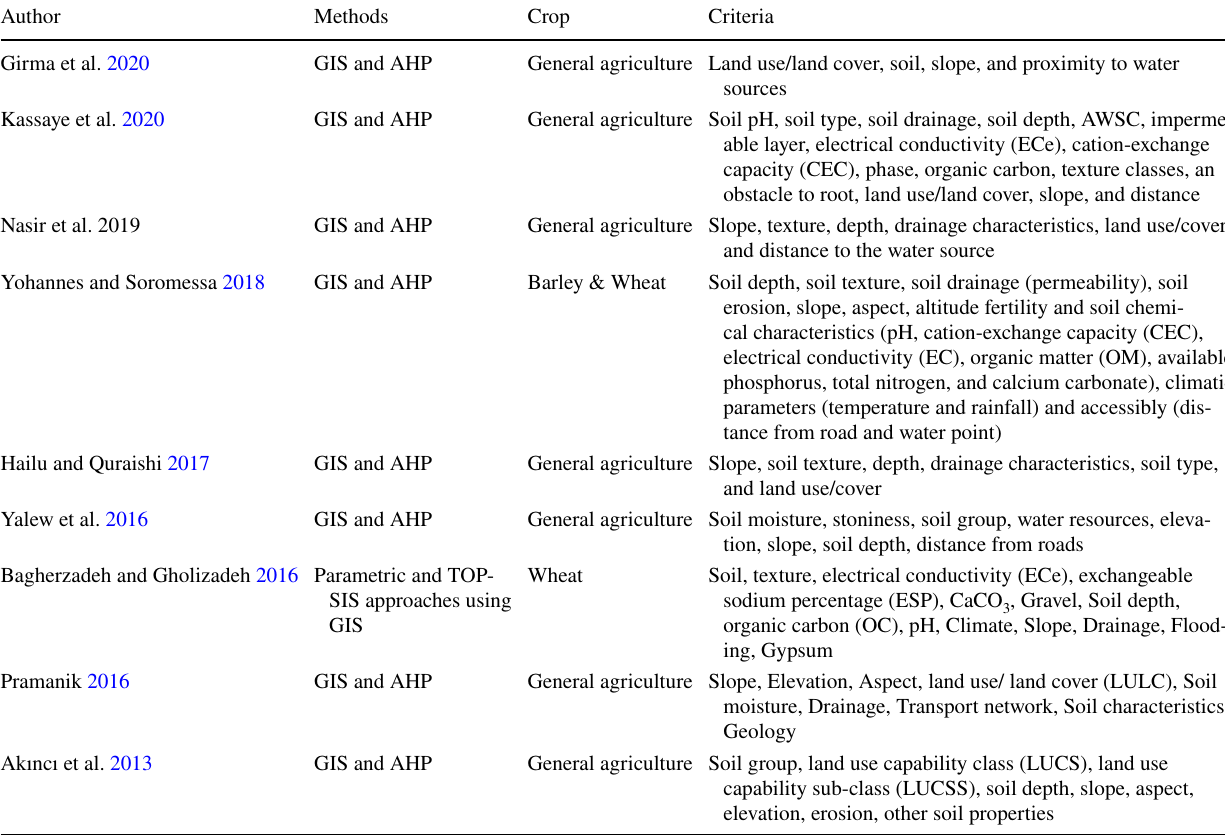
Table 2 Studies on land suitability evaluation